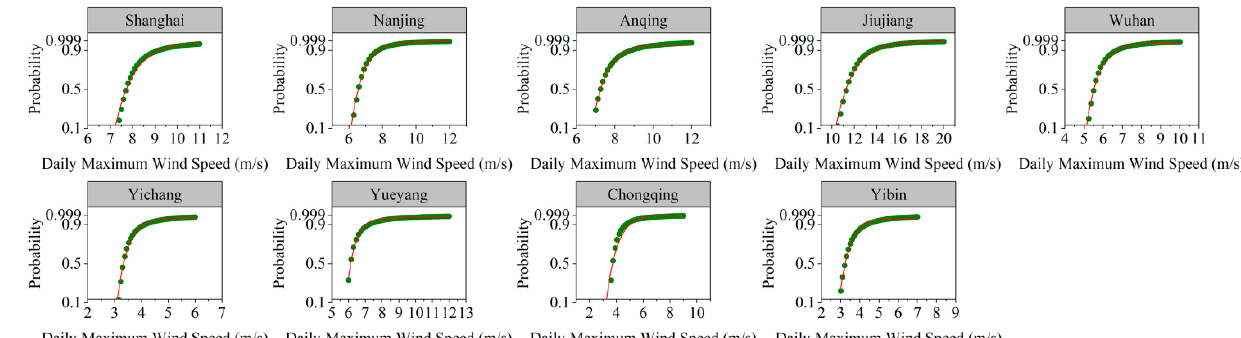
Figure 5. probability ‒ wind speed plots of the cumulative GEV distribution for nine ports from 1979 ‒ 2020 (Dotted line: observed wind speed; red line: theoretical wind speed). 1979–2020 (Dotted line: observed wind speed; red line: theoretical wind